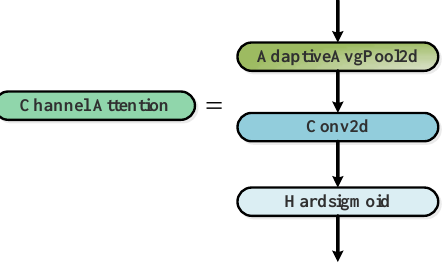
Figure 7. The framework of the Channel Attention